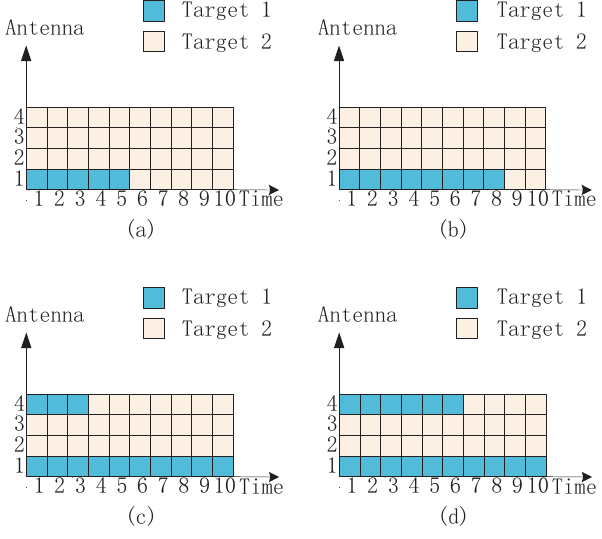
Figure 5. The antenna allocation results via the antenna-time allocation scheme in the scenario of Figure 2: ( a ), ( b ), ( c ) and ( d ) show the antenna allocation results at the transmitted power of 5 dB, 10 dB, 15 dB and 20 dB,